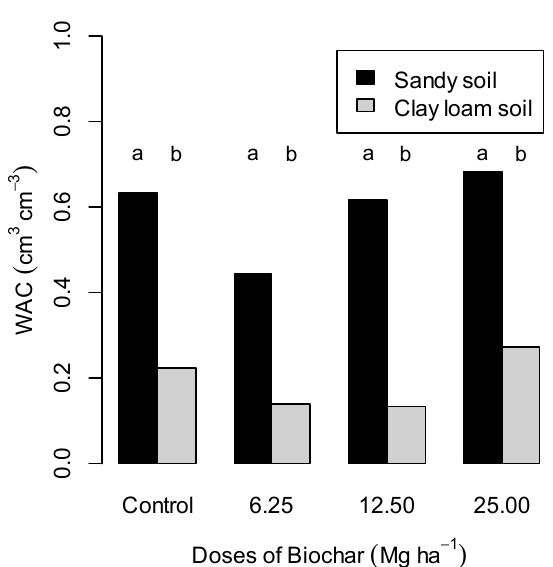
Figure 5. Effect of biochar doses on plant-available water content in clay loam and sandy soil. AWC Plant available water content.